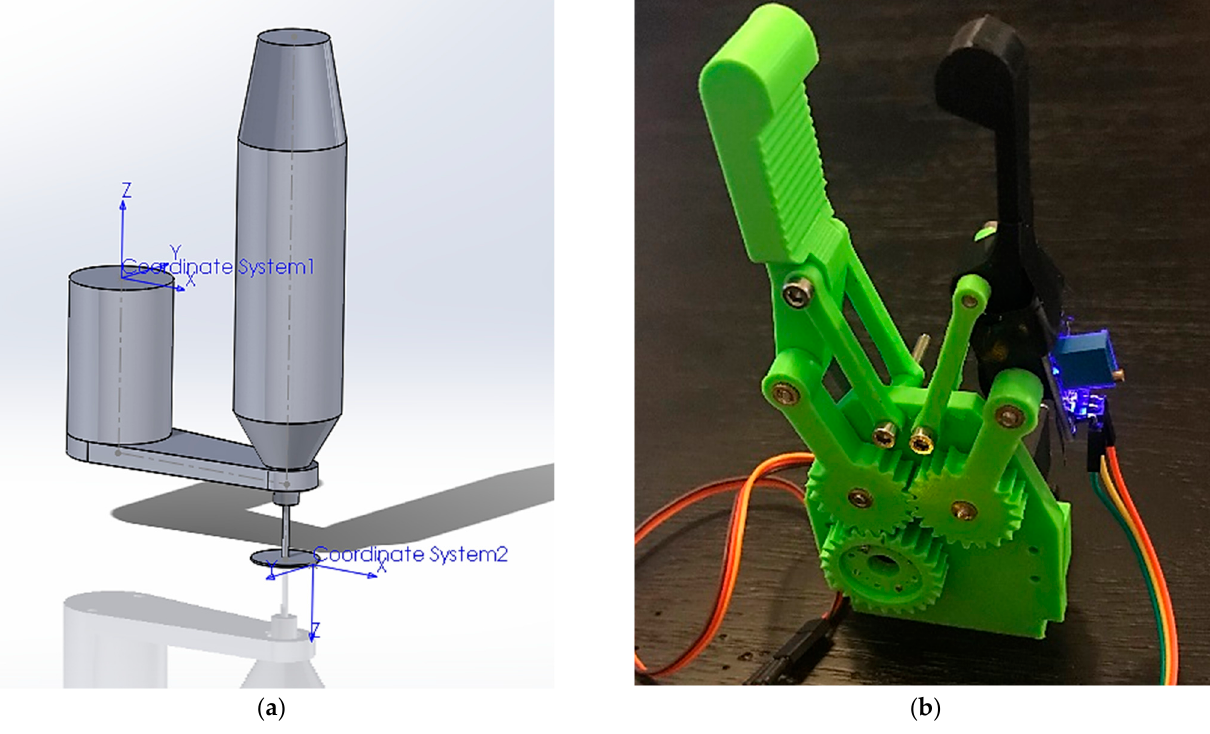
Figure 3. ( a ) The CAD model of the cutting tool, ( b ) the 3D-printed griper with servo actuator and gear-driven coupled planar linkage system with force feedback.